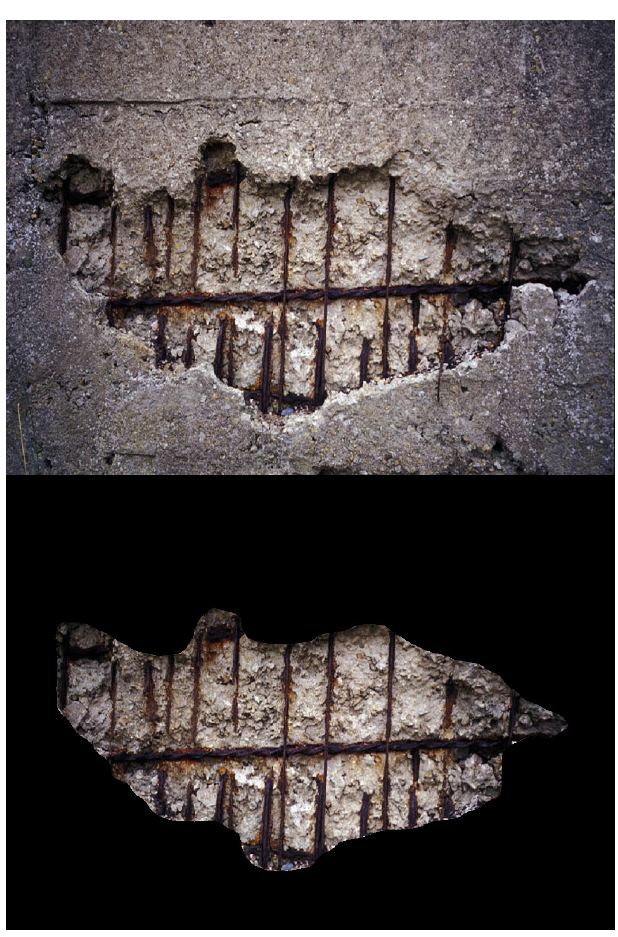
Figure 3. Example of spalling